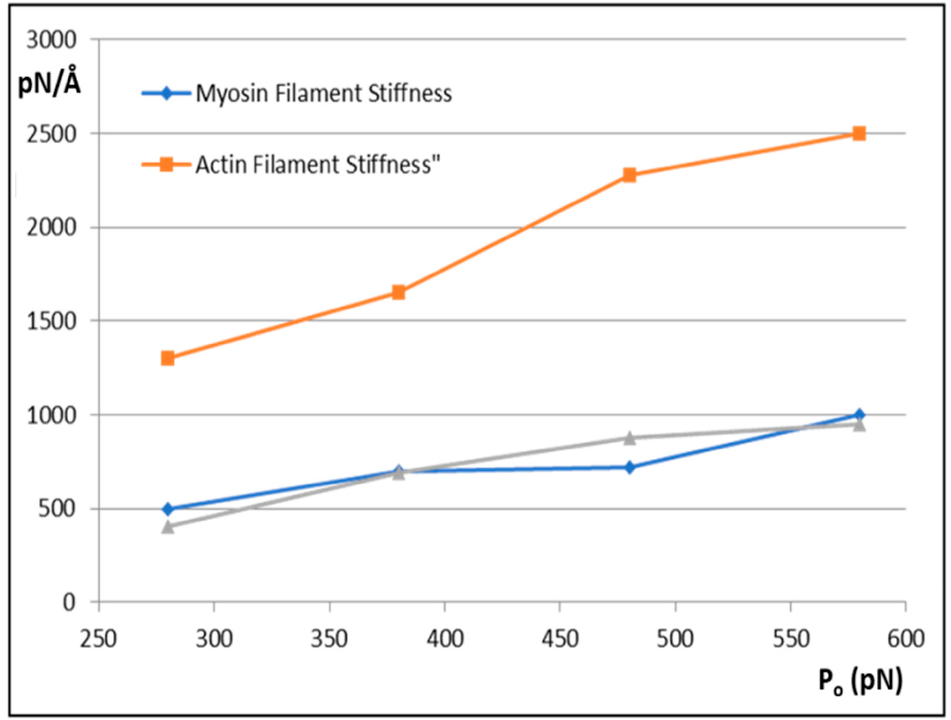
Figure 6. The variation of myosin filament stiffness (k m ; blue) and actin filament stiffness (k a ; orange) with tension P o assuming that the X-ray spacing changes in the M15 and A13 peaks are as observed by Huxley et al. [5] and Wakabayashi et al. [6]. The grey curve shows the myosin filament stiffness if the same attachment number is achieved with a different set of labelling parameters in MusLABEL.